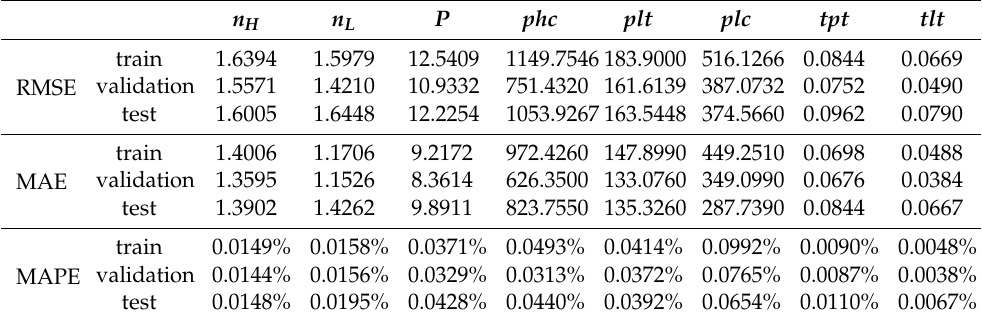
Table 4. RMSE, MAE and MAPE of normal pattern group.